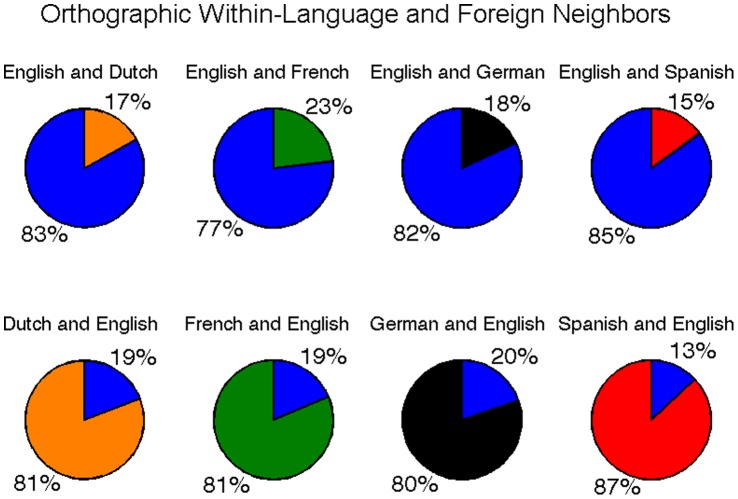
Ratio of within-language and foreign orthographic neighbors as part of total neighborhood size for each word with at least one neighbor.The top row compares the proportion of English within-language neighbors (blue) to foreign neighbors in each other language. The bottom row compares the proportion of within-language neighbors in each language to foreign (i.e., English) neighbors (blue).